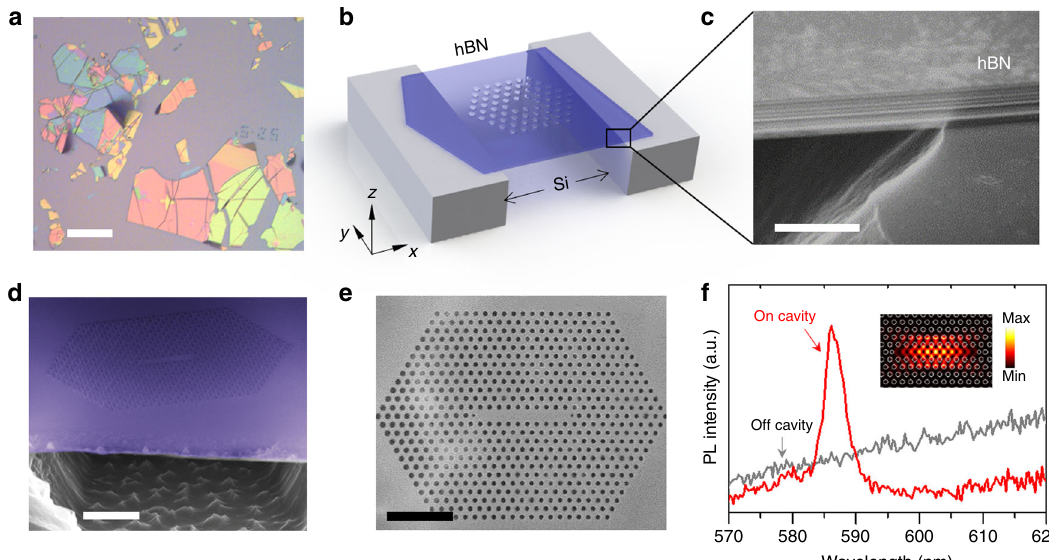
Fig. 1 Free-standing hexagonal boron nitride 2D photonic crystal cavities. a Optical microscope image of exfoliated hBN crystals on a silicon substrate. The scale bar corresponds to 50 µ m. b Schematic of a free-standing hBN cavity on a trenched silicon substrate. c SEM image of the hBN showing the layered structure. The scale bar corresponds to 500 nm. d false color SEM image (45°) of a free-standing hBN photonic crystal cavity fabricated using a combination of RIE and EBIE. The scale bar corresponds to 2 µ m. e Top view of a 2D photonic crystal cavity. The scale bar corresponds to 2 µ m. f Photoluminescence spectra with a laser exciting the cavity mode (red) compared with an off-cavity excitation (gray). The inset depicts the electric fi eld intensity pro fi le of the fundamental mode for the cavity calculated using 3D